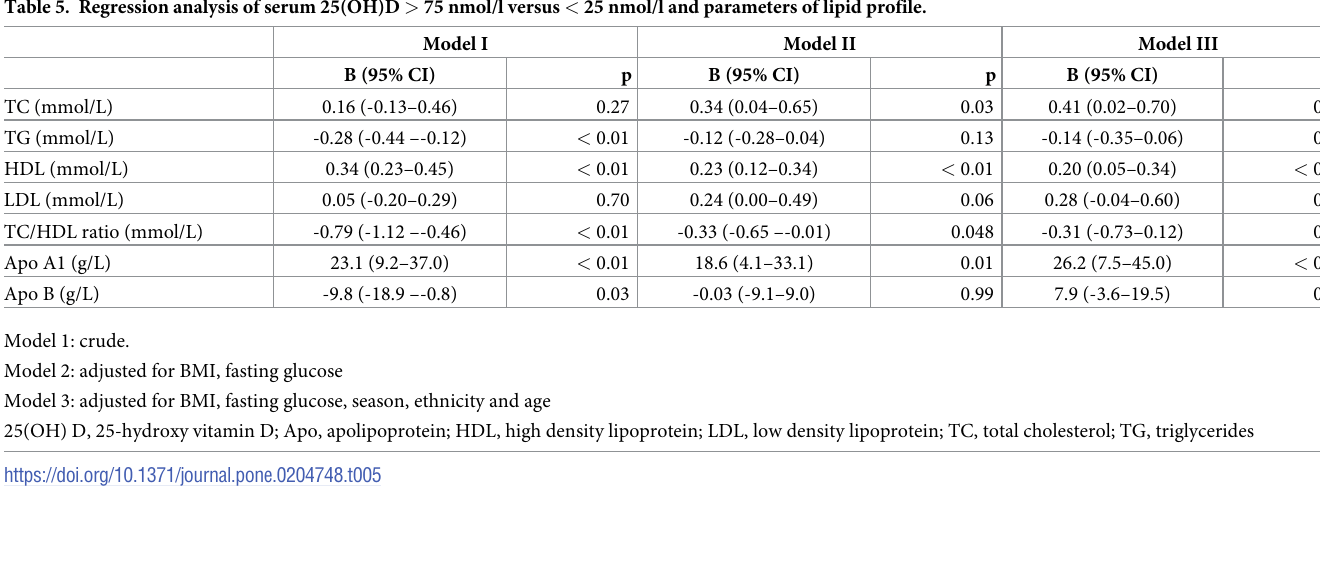
Table 5. Regression analysis of serum 25(OH)D > 75 nmol/l versus < 25 nmol/l and parameters of lipid profile. Model I